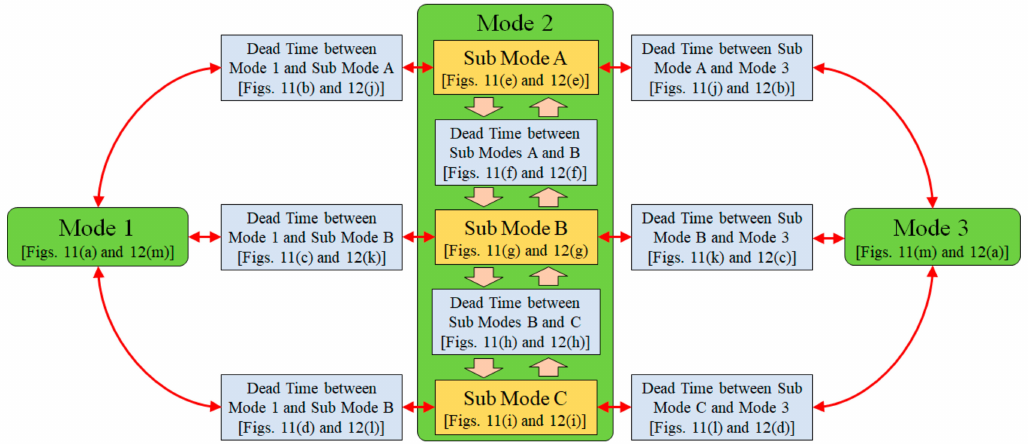
Figure 10. Mode transition